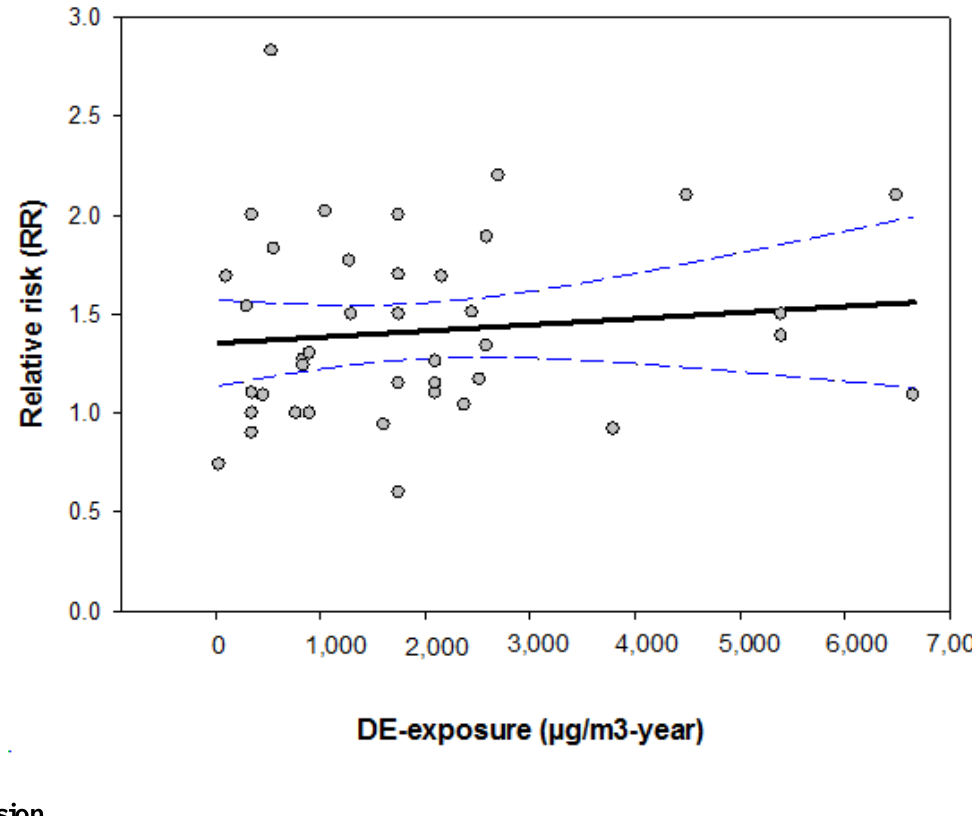
Figure 2. Effects of DE-exposures on the risk of lung cancer given in previously published case-control